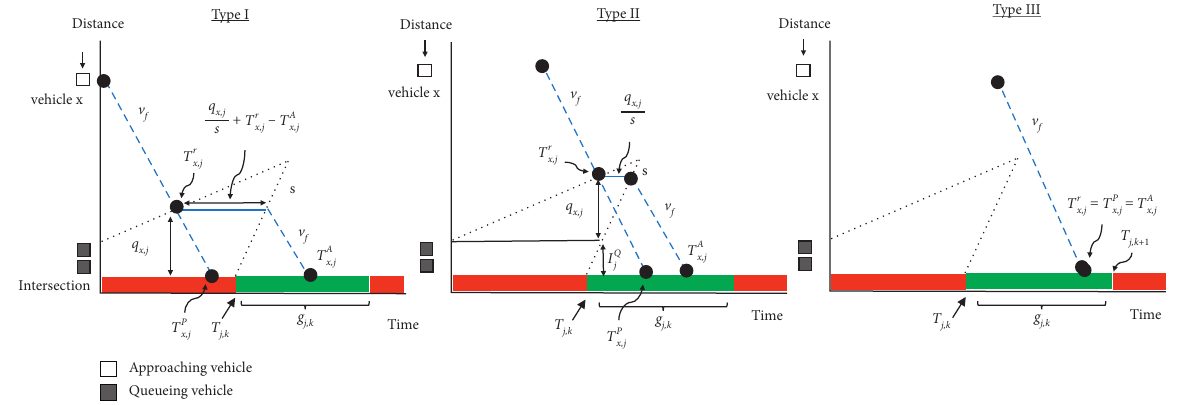
Figure 6: Illustration of three types of